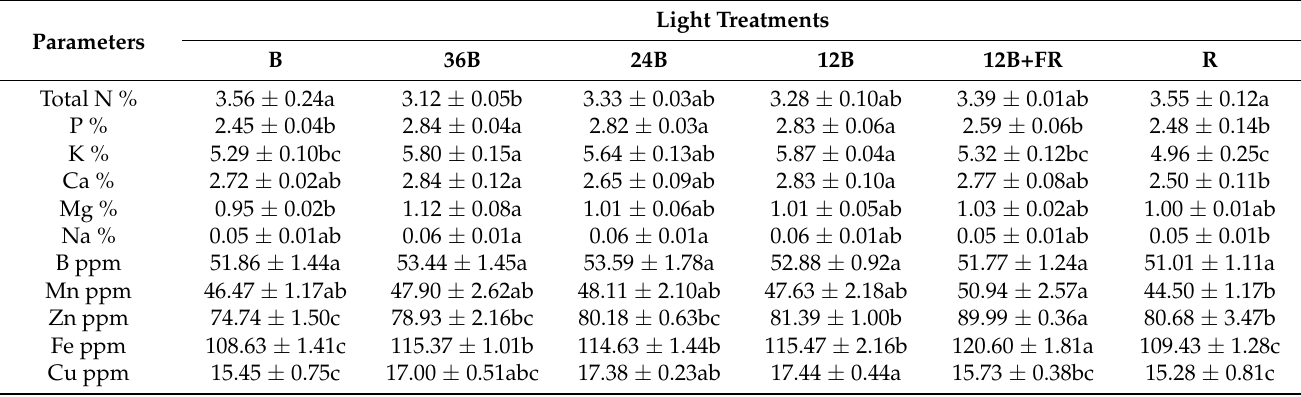
Table 3. Nutrient content of grafted watermelon seedlings treated for seven days in the healing chamber with six light treatments, plus seven days in the greenhouse. Mean values ( ± SE) within a nutrient followed by different letters are significantly different (a <